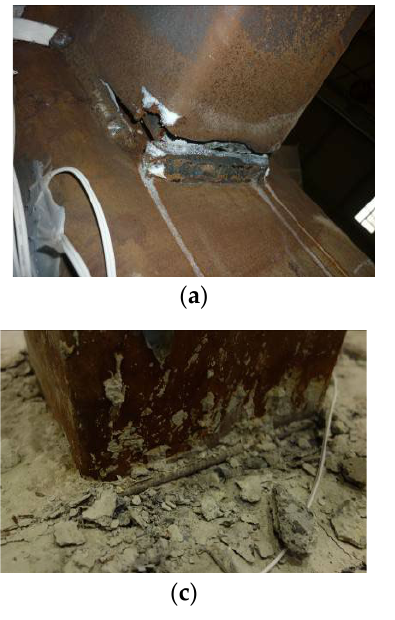
( c ) Figure 11. Comparison of skeleton curves of three specimens: ( a ) specimen C-1; ( b ) specimen C-2; ( c ) specimen C-3.